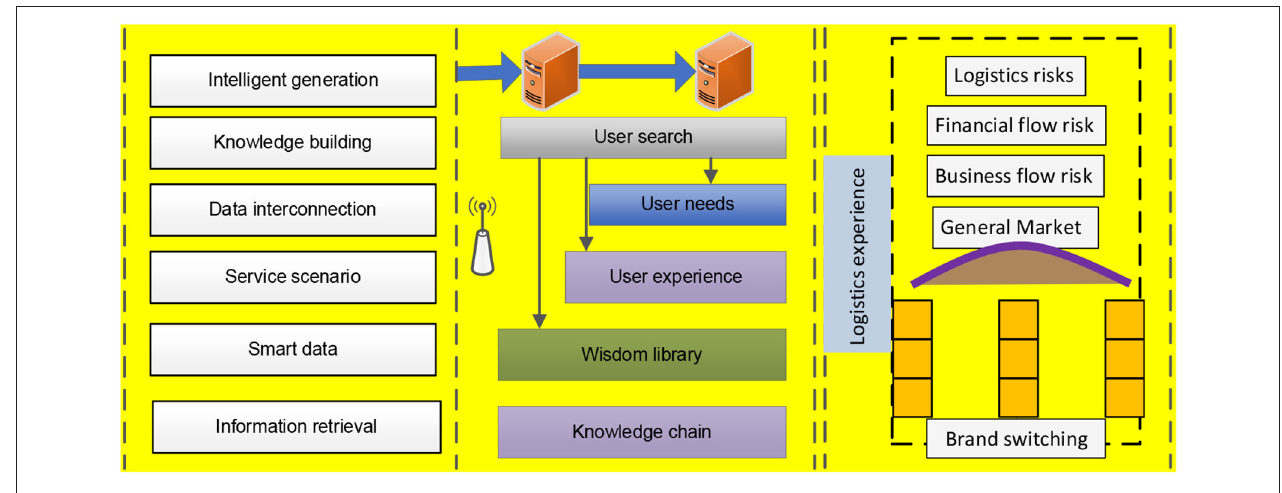
FIGURE 1 | Brand switching intention model.